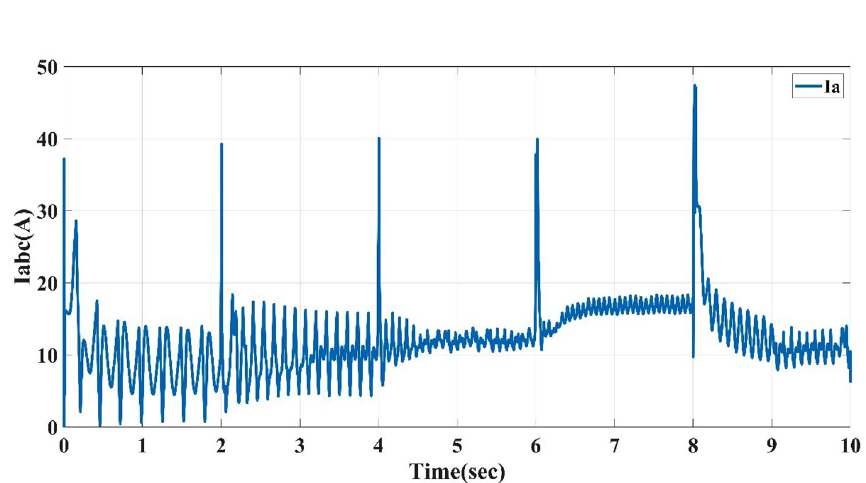
Figure 10. The AFPMSM instantaneous current at full load torque of 11 N m.